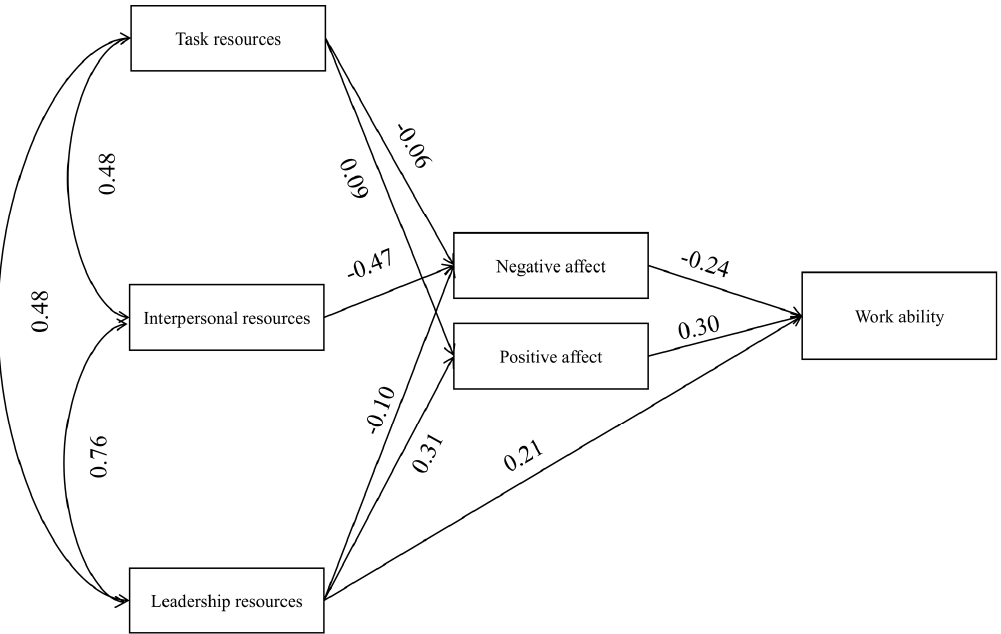
Figure 3. The final model for shift workers with standardised significant parameters consistent with the best-fit model.